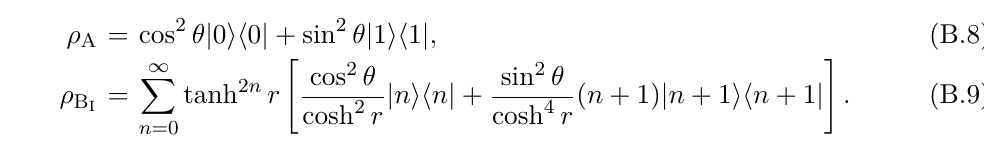
) as a function of acceleration parameter I